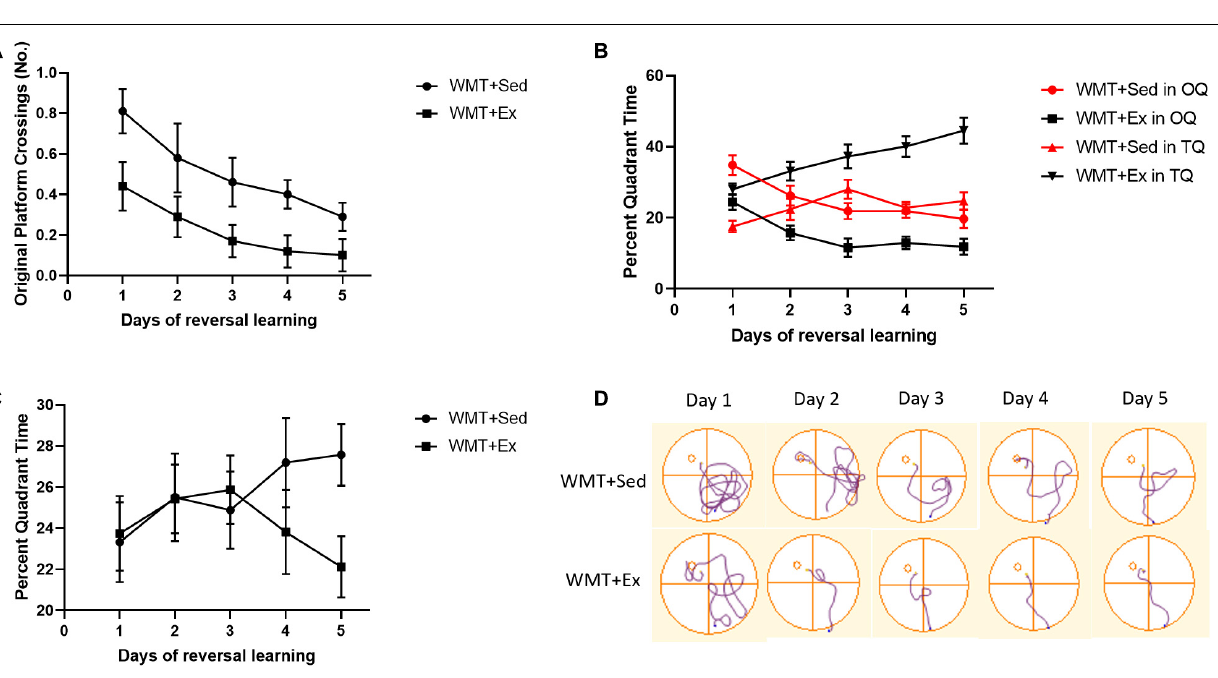
F ( 4 , 96 ) = 0.161, p > 0.05, two-way repeated-measures